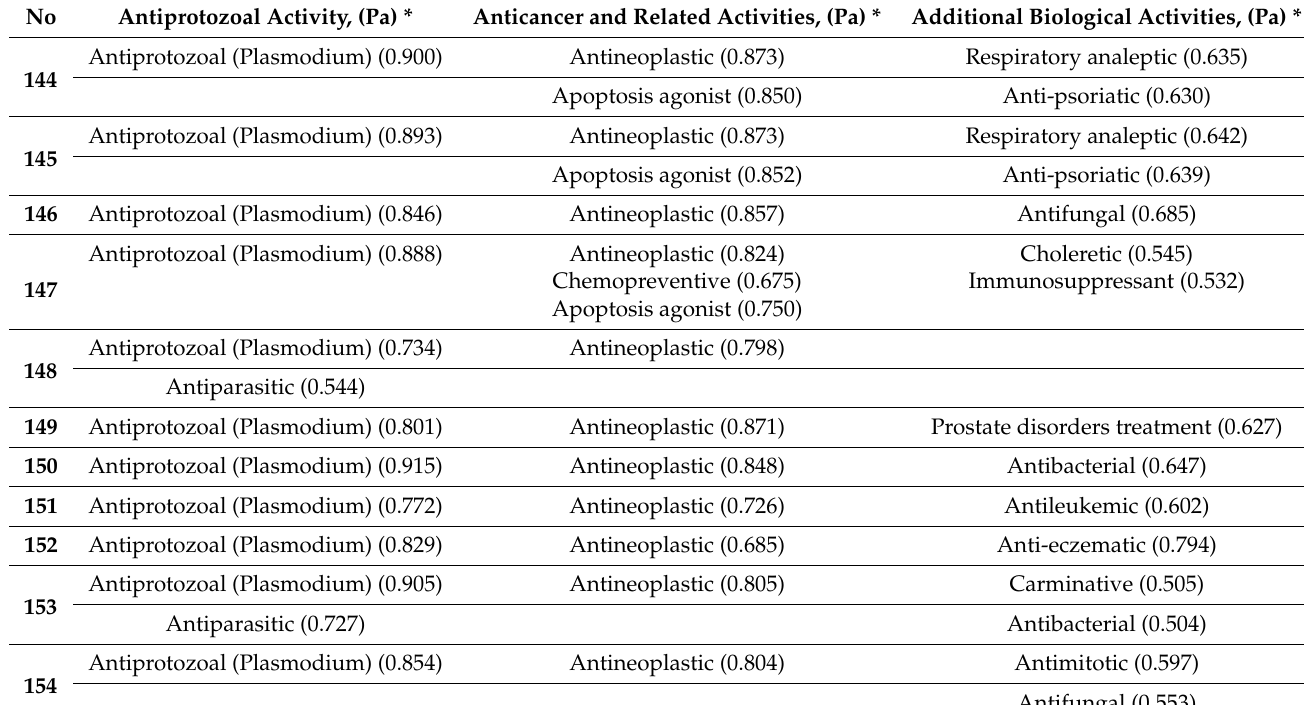
Table 10. Biological activity of natural polycyclic peroxides derived from